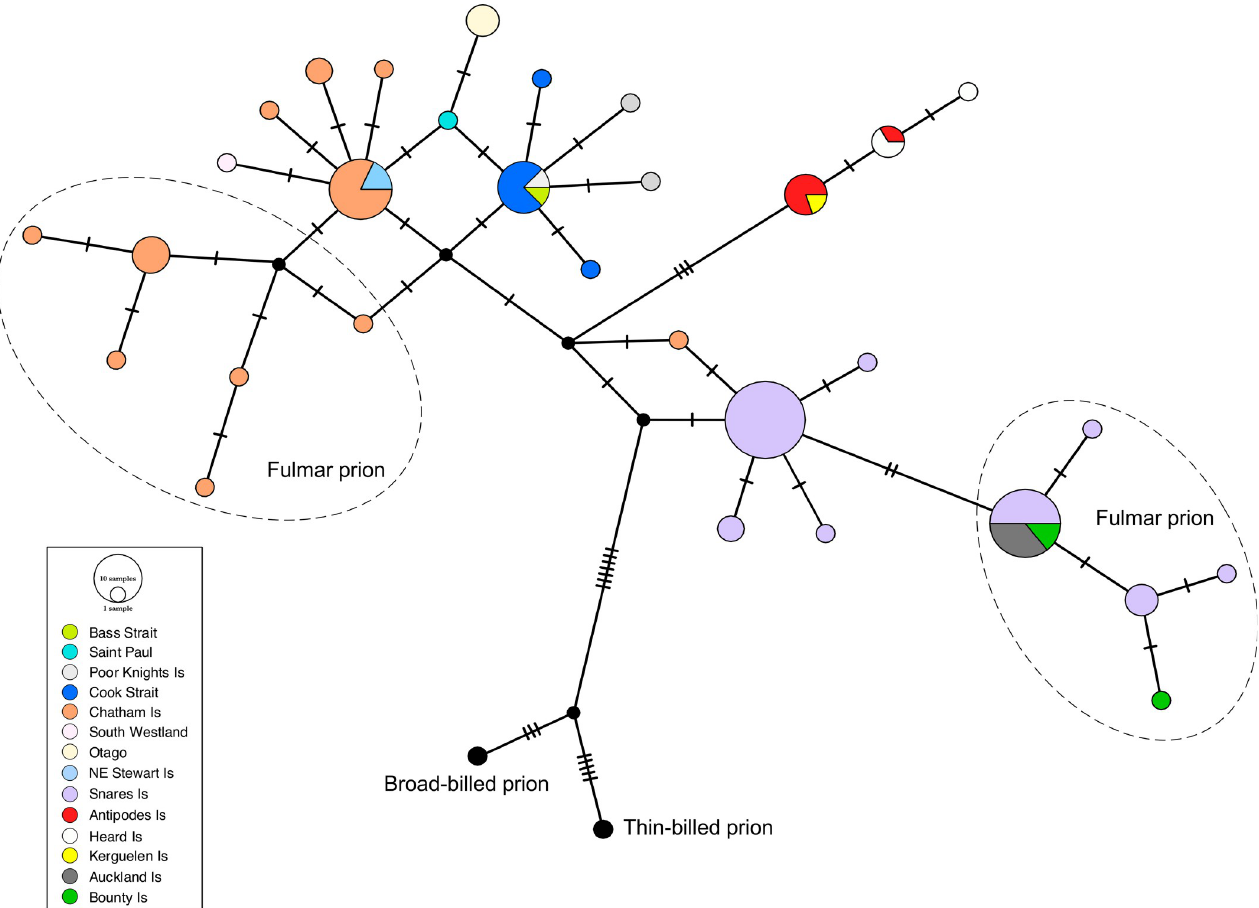
Fig 2. COI median joining network of fairy and fulmar prions with colour-coded sampling localities. Fulmar prion samples are encompassed by a dashed line. The size of each circle is proportional to haplotype frequency. Hatch marks represent additional mutational steps separating haplotypes.